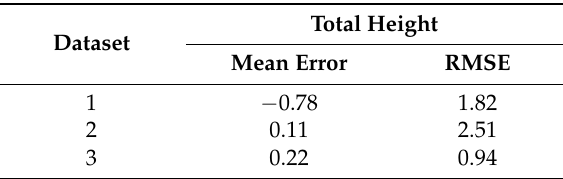
Table 8. Accuracy assessment of total height regression models for every dataset: Mean errors and Root-mean-square errors (RMSE).